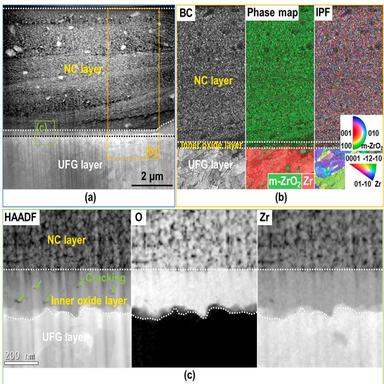
Cross-sectional microstructure of worn scar on the uncoated cladding: (a) SEM image; (b) TKD images; and (c) STEM-HAADF image and the corresponding EDX maps.